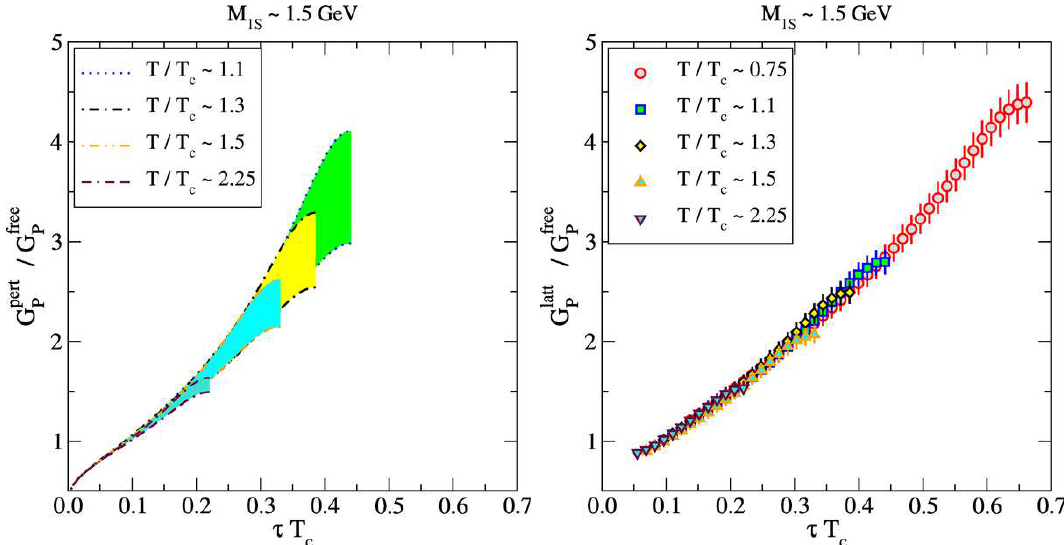
Figure 4 . Left: Imaginary-time correlators corresponding to spectral functions such as those ) = 1 GeV, plotted by expressing τ in fixed units, chosen as T c . The shown in figure 1, for m (¯ µ ref uncertainty bands have been obtained by varying the central value of m (¯ µ directions. Right: Lattice data from figure 3(right) in the same units, including now also the lowest temperature at T < T c .